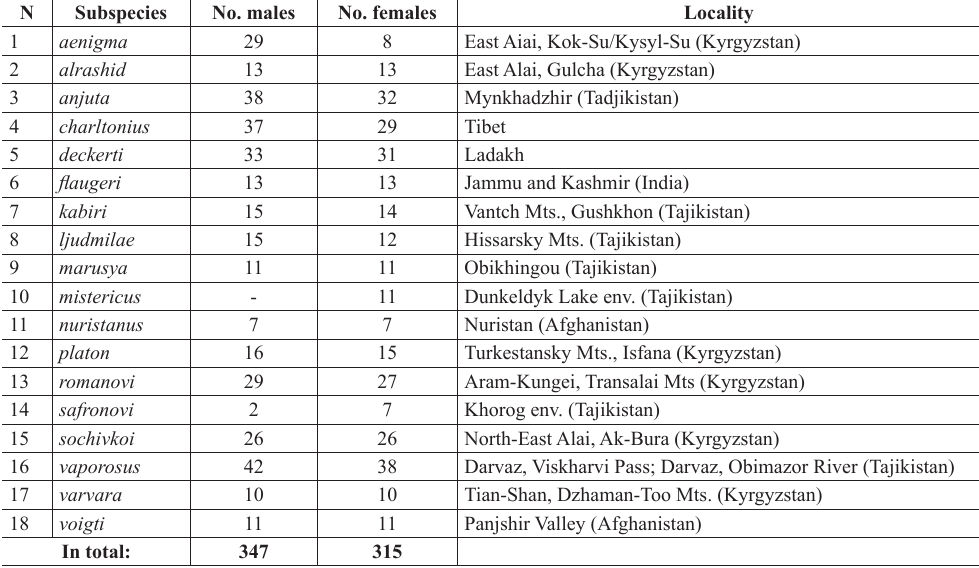
Table 1. Material used in the morphometric